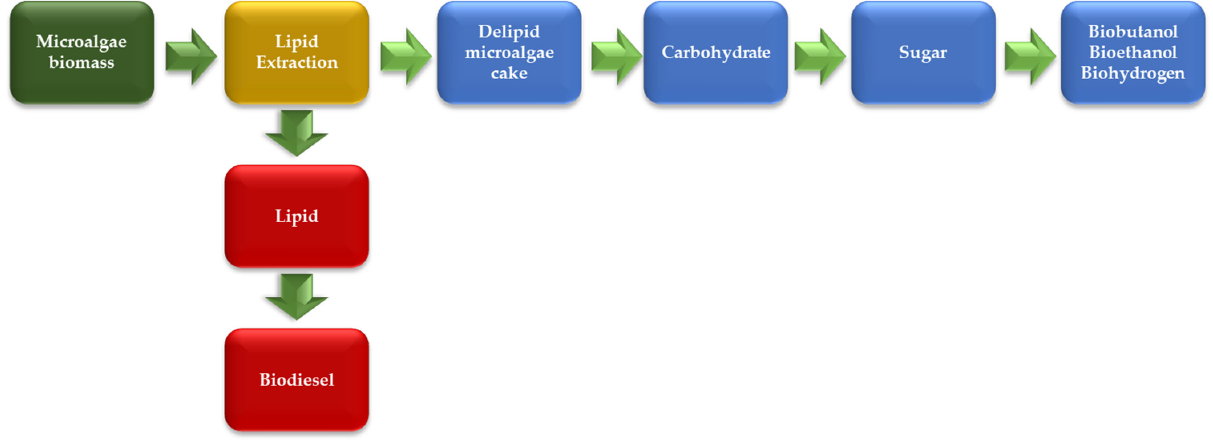
Figure 2. Flow diagram of microalgal biomass pretreatment process prior to carbohydrate polymer production and fermentation. Table 4. Bioethanol production from different microalgal biomass feedstock.